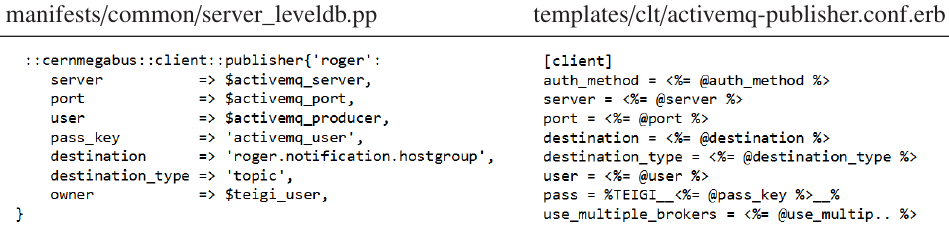
Figure 1. CERNMegabus architecture